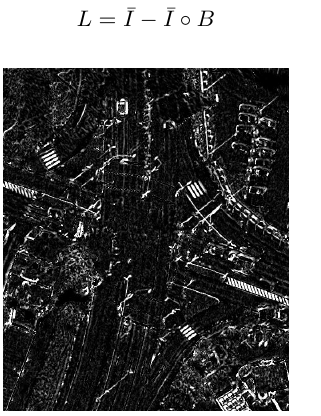
Figure 9. Same section as in fig. 8, result after filtering narrow objects relatively darker than their surrounding (shown in white) From the known geographical position and acquisition time of the aerial or satellite image the azimuth angle of the casted shadow can be calculated. Using the position of the crossing ( 8 . 597 ◦ E, 50 . 129 ◦ N) and the acquisition time of the aerial im- age (2017-04-20, 13:50:42 UTC) we get a sun azimuth angle of 230 . 66 ◦ and a sun zenith angle of 49 ◦ . The narrow dark objects image L is filtered using a gabor-filter in azimuth angle direc- tion with σ = 2 . 0 and one period to an image G as shown in fig. 10,